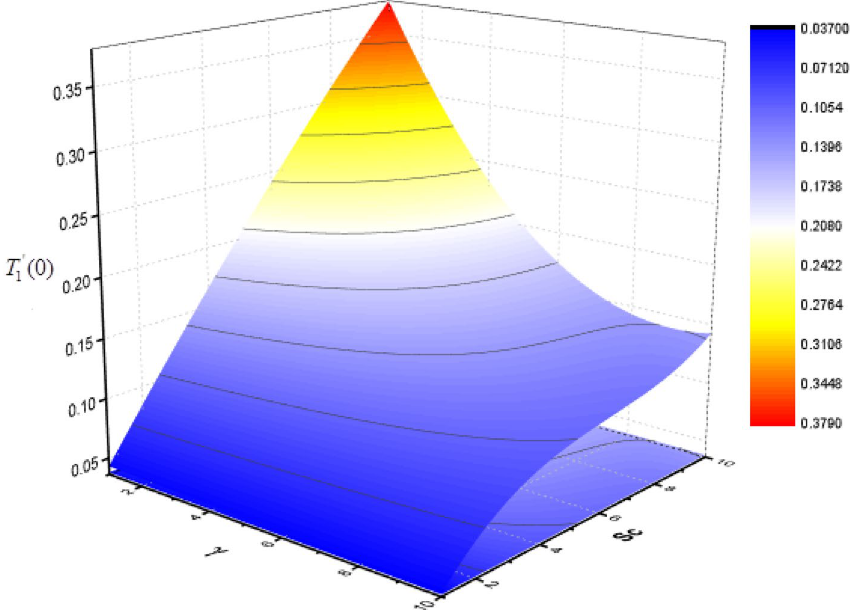
Figure 23. Consequence of Sc and ϒ on T ′ 1 ( 0 ) .